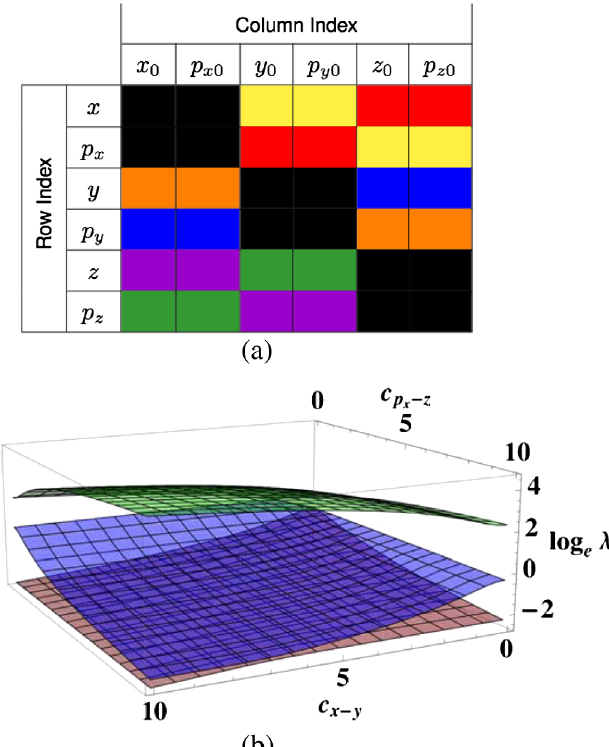
FIG. 5. (a) Table of acceptable correlations coupling all three dimensions that lead to two tiny eigenemittances and one large eigenemittance. Acceptable pairs of correlations are one from each of the two groups of the same color, with the black areas as excluded, where the row index is a function of the column index. (b) Eigenemittance evolution as a function of x - y and x 0 - z correlations [using the yellow sections from part (a)]. When both correlations vanish, the eigenemittances are the initial uncorrelated emittances of 1 = 1 = 1 (cid:5) m